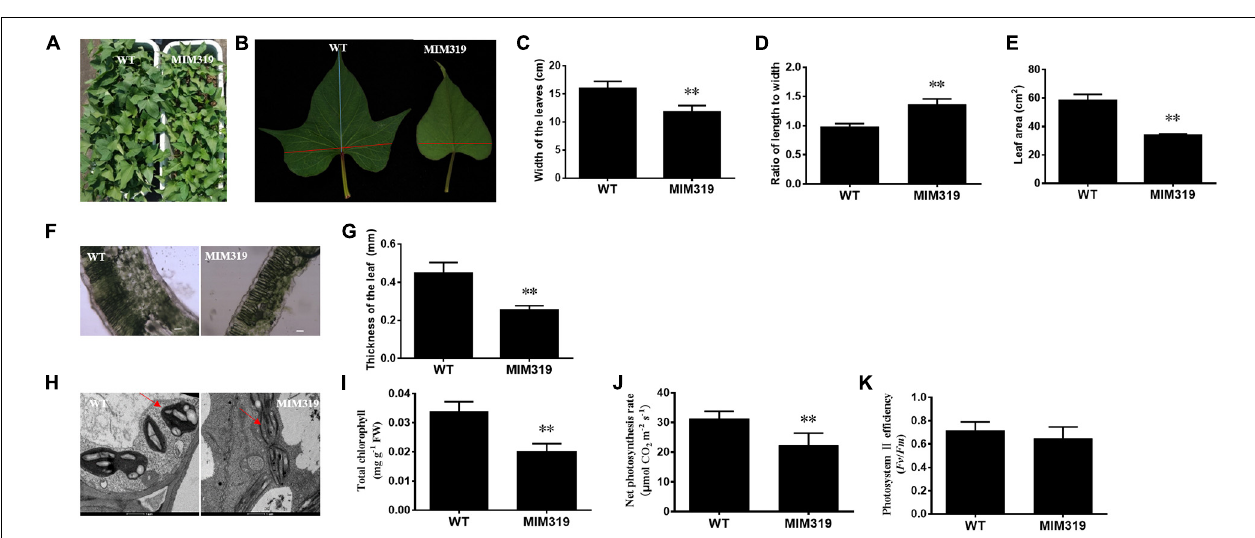
FIGURE 7 | The phenotypes and anatomical morphology of MIM319 and WT sweet potato leaf. (A) Phenotype of the whole plant of WT and MIM319. (B) Phenotype of the third fully-expanded leaf of WT and MIM319. (C–E) The width, ratio of length to width, and area of the third fully-expanded leaf of WT and MIM319. (F) The microstructure of the hand-sliced third-fully expanded leaves of WT and MIM319 observed using an optical microscope. Bars are 50 µ m. (G) The thickness of the third fully-expanded leaf of WT and MIM319. (H) The TEM image of the third fully-expanded leaf of WT and MIM319. The red arrows indicate the chloroplast. Bars indicate 1 µ m in length. (I–K) The total chlorophyll, net photosynthesis rate, and photosystem II efficiency of WT and MIM319. The error bars and asterisks indicate the SD and statistical significance of 10 biological replicates (Student’s t -test; ∗∗ P < 0.01),